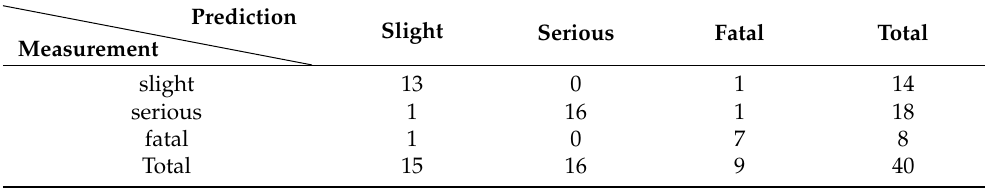
Table 3. Results of prediction power verification for the proposed RORC severity prediction